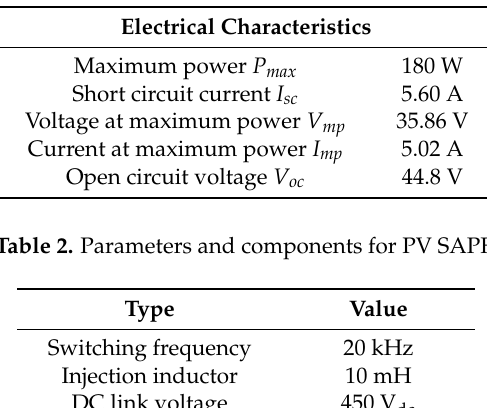
Table 1. Characteristics of the PV module at 1000 W/m 2 .